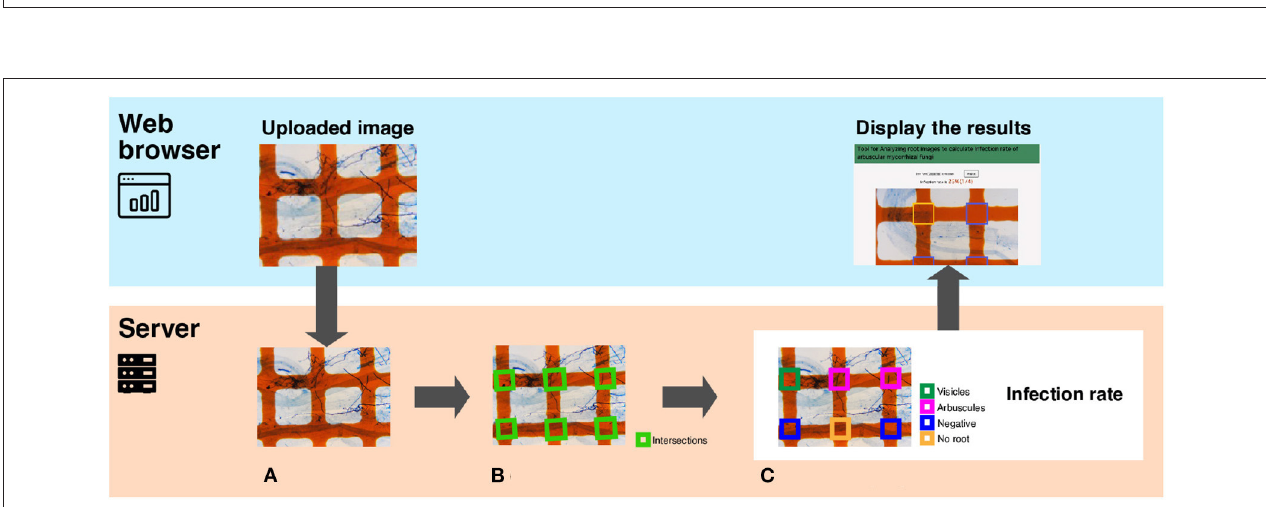
FIGURE 2 | A system overview of TAIM. The system consists of a client and a server. The client, implemented on a web browser, receives the microscope slide images with the grid filter from users and shows the calculation results of the AMF colonization degree. The server receives images, calculates the AMF colonization degree, and returns the calculation results to the web client. The process for calculating the AMF colonization degree by the server are following; (A) The input image is a microscope slide image with a grid filter for calculating AMF colonization. (B) The intersections denoted by green rectangles are detected. They are used as sampling areas for calculating the AMF colonization degree. (C) Categorization results are visualized with different colors. The magnification of the slide images was